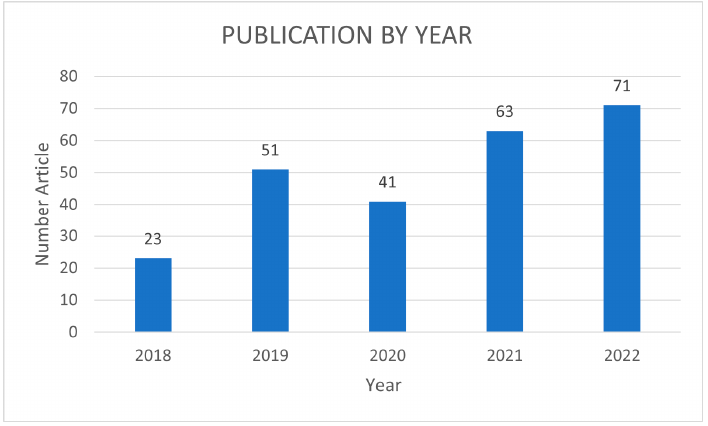
Figure 4. Publication by year.